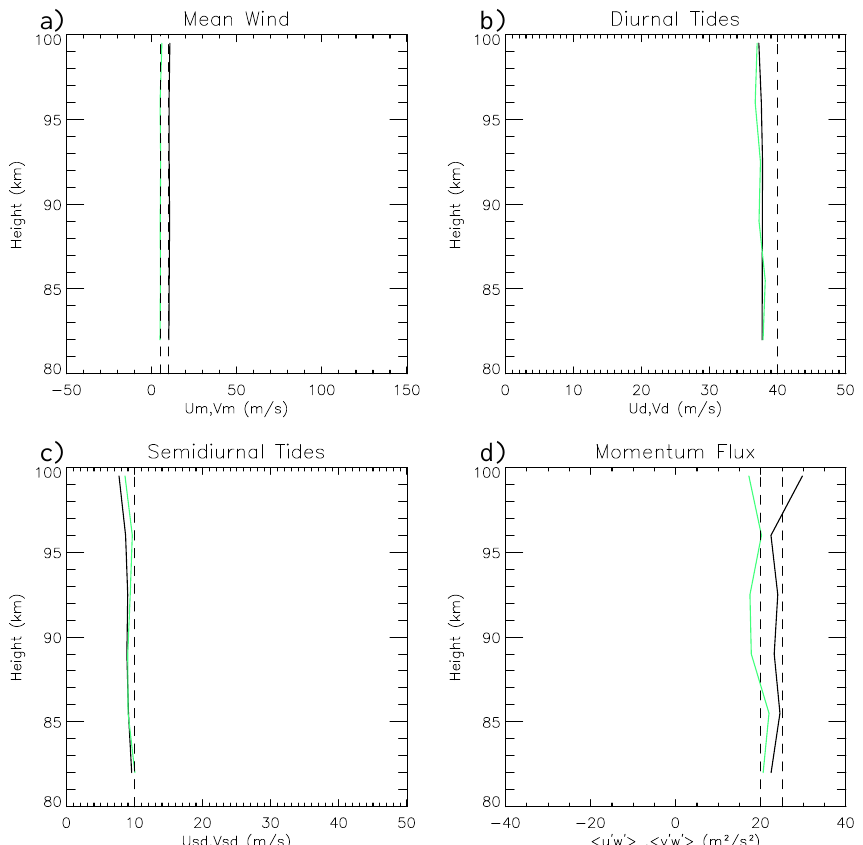
Fig. 12. Monthly specified (dashed) and recovered (solid) distributions of (a) zonal (black) and meridional (green) mean winds, (b) diurnal tide amplitudes, (c) semidiurnal tide amplitudes, and (d) GW momentum fluxes for mean, tidal, and GW fields specified in Case 1. Recovered amplitudes and momentum fluxes were obtained with actual January 2005 meteor